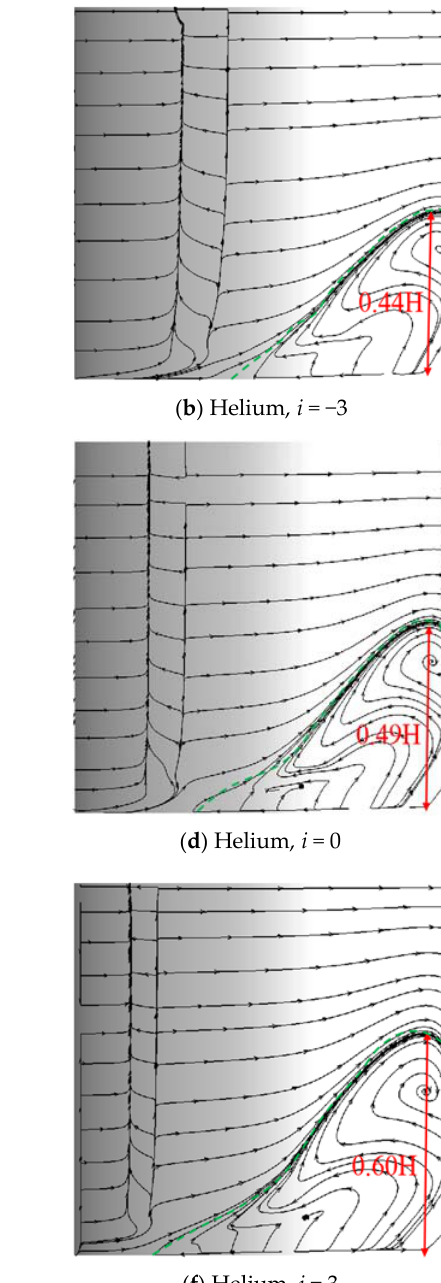
( f ) Helium Figure 11. Static pressure coefficient (Cp) and static pressure ratio ( π ) distribution at 98% span for dissimilar working fluids (i = 0, Ma = 0.7).